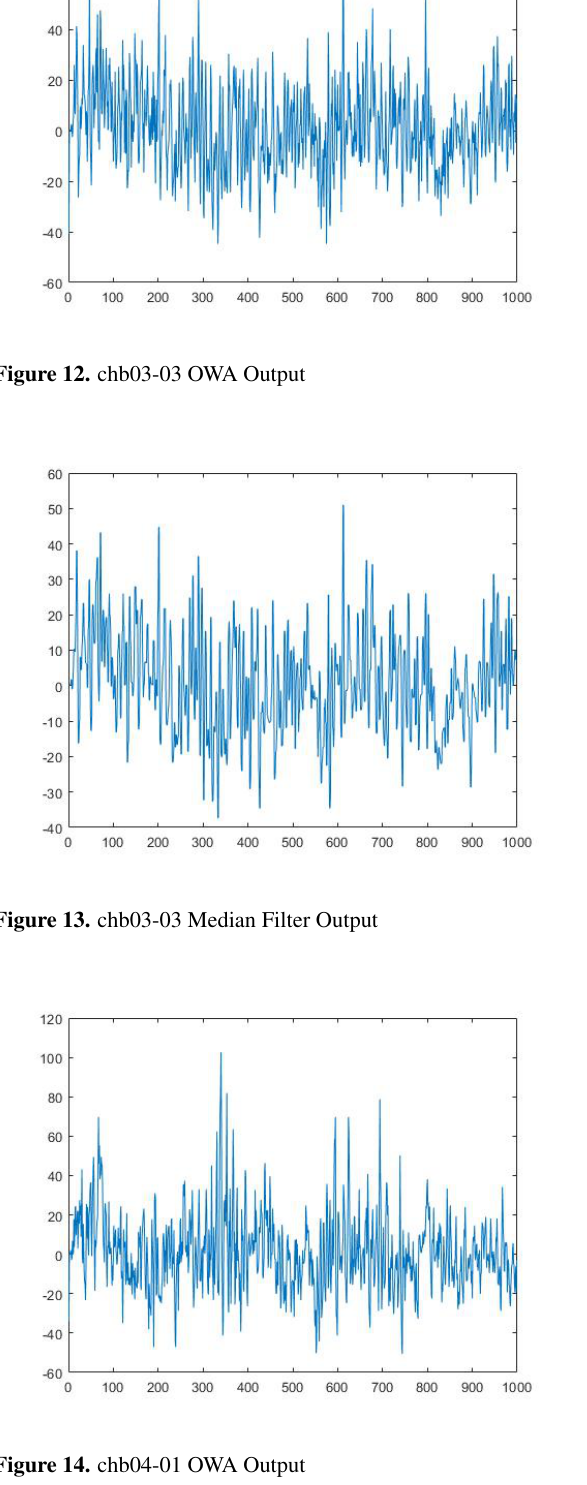
Figure 14. chb04-01 OWA Output